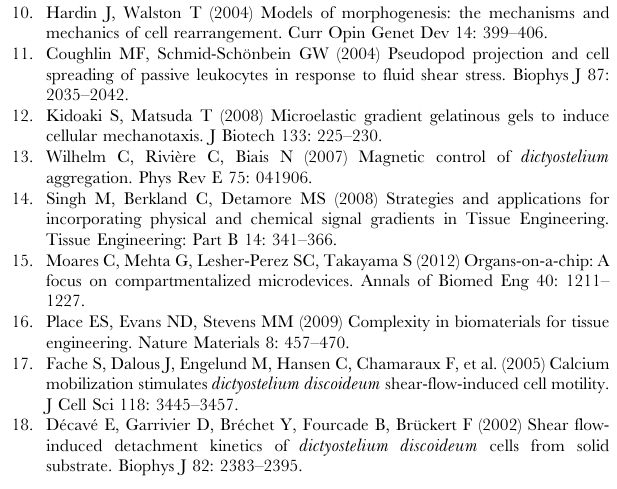
Table S2 Cell populations considered for the one- dimensional cell motion control, cell reversal and cell trapping experiments. The Lagrangian path of each individ- ual cell is tracked in the observation area using a reduced sampling time, t s , of 3.5 seconds which was found appropriate given the average cell speed of approximately 0 : 09 m m : s { 1 . The smallest population size comprises 205 cells, which is sufficient to yield statistically relevant